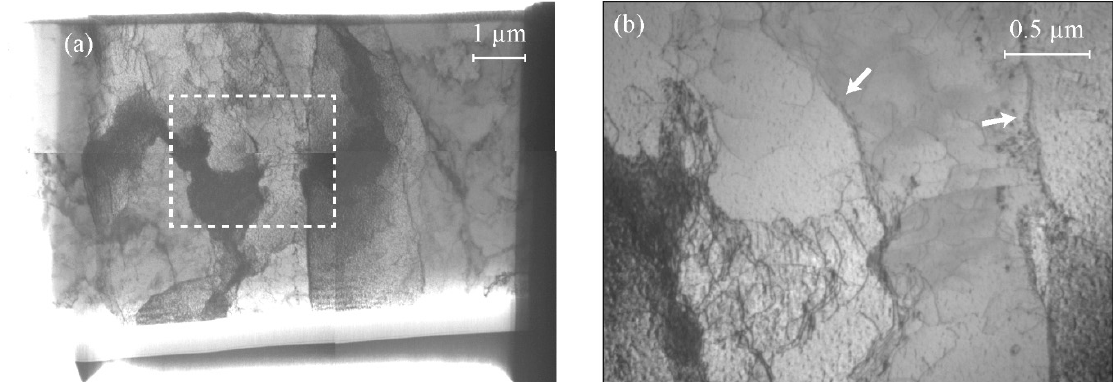
Figure 5. ( a ) TEM thin foil extracted from the contact region between two particles during densification of a Ni powder by SPS. ( b ) Zoom-in corresponding to the white dashed rectangle in ( a ) showing the presence of dislocations wall associated to dislocation recovery mechanisms [24]. Reproduced with permission from Metallurgical and Materials Transactions: A , published by Springer Nature, 2018.